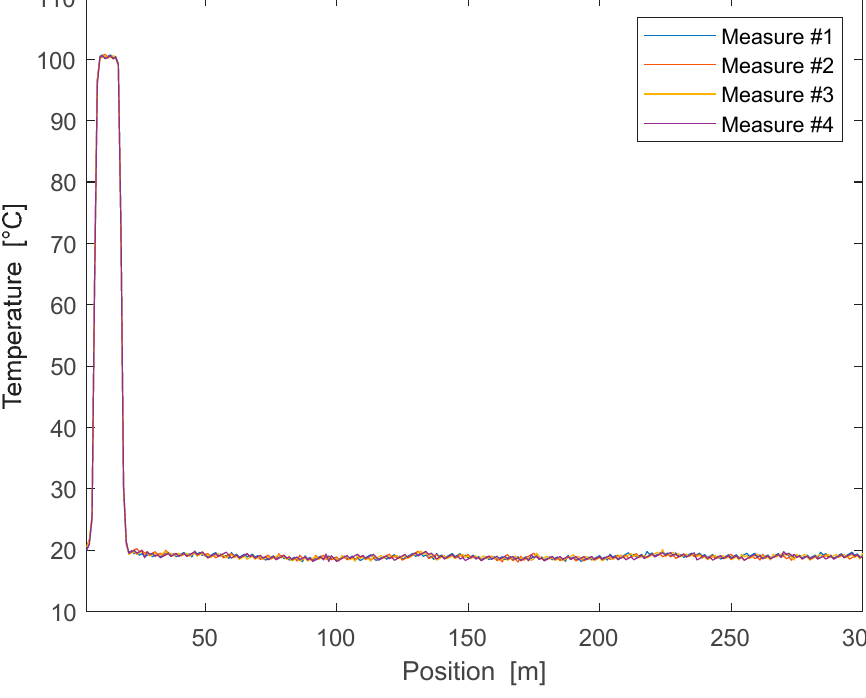
Figure 6. Temperature profile acquired using the assembled DTS in four successive runs.